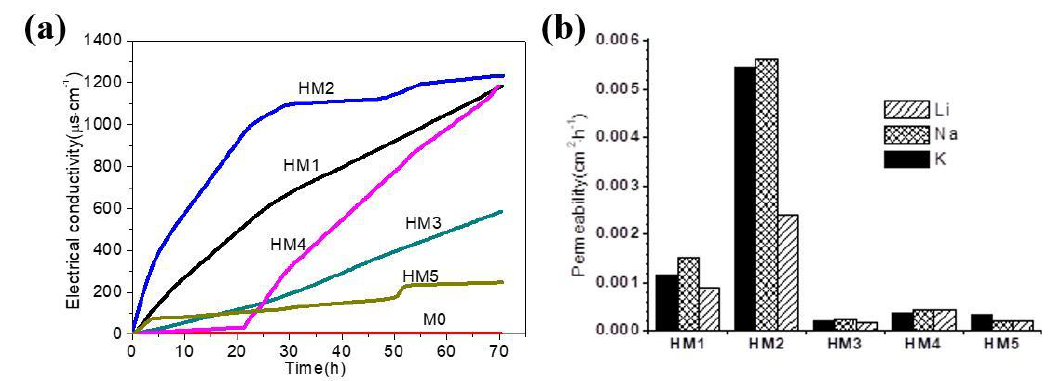
Figure 7. ( a ) Electrical conductivity of Li + , Na + , and K + in M0 and HM1–HM5; ( b ) permeability values of Li + , Na + , and K + cations in HM1–HM5.